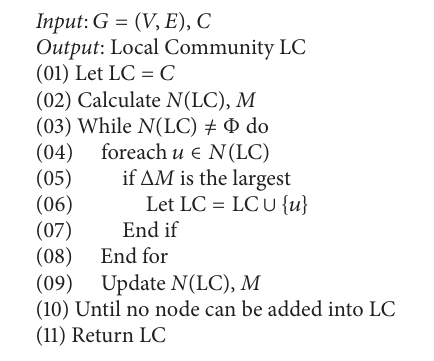
Table 1: LFR benchmark network information.